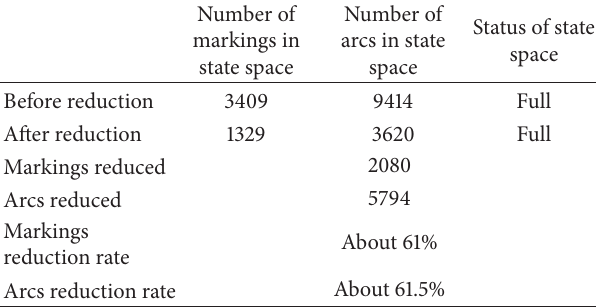
Table 2: The comparison of state reports before and after